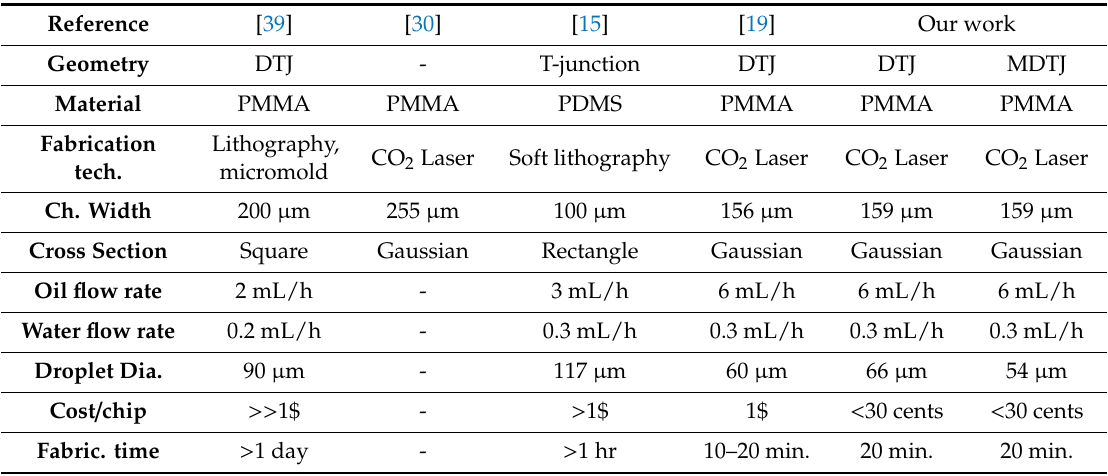
Table 2. Illustrates a comparison between our work and some previous experimental work close to our channel